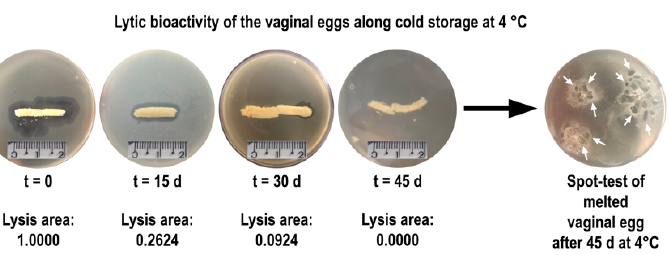
Figure 18. Results from the cold storage stability assessment of the vaginal eggs integrating both phage particles, in terms of evolution of lytic bioactivity. Full scale bar represents 2 cm.